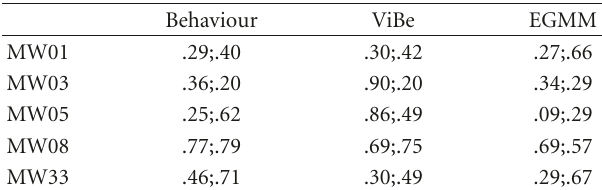
Table 1: Sequence average precision-recall pairs for behaviour subtraction, ViBe, and